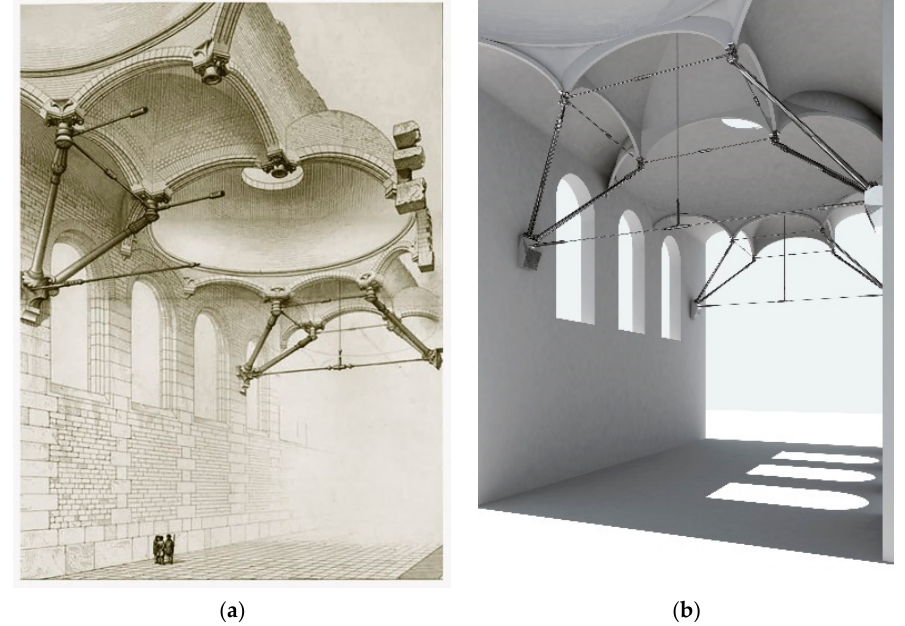
Figure 1. ( a ) Project proposed by Viollet-le-Duc for an ideal structure. (From Entretiens sur l’architecture , published in 1868). ( b ) Three-dimensional image recreated with AutoCAD + 3D Studio + Maya.